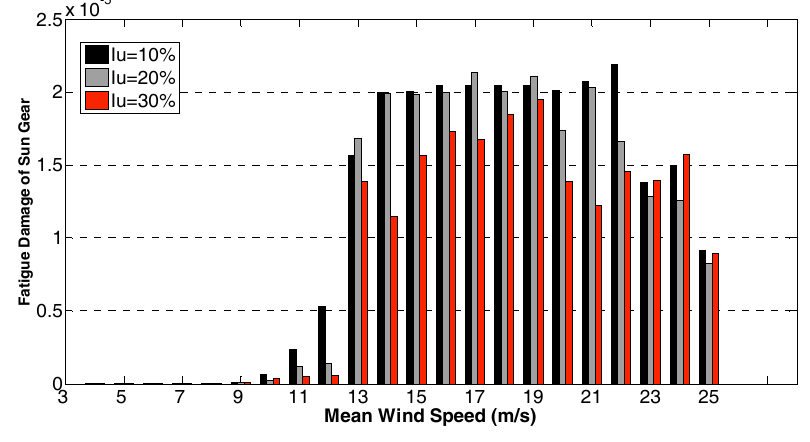
Figure 14. Fatigue damage of a sun gear.